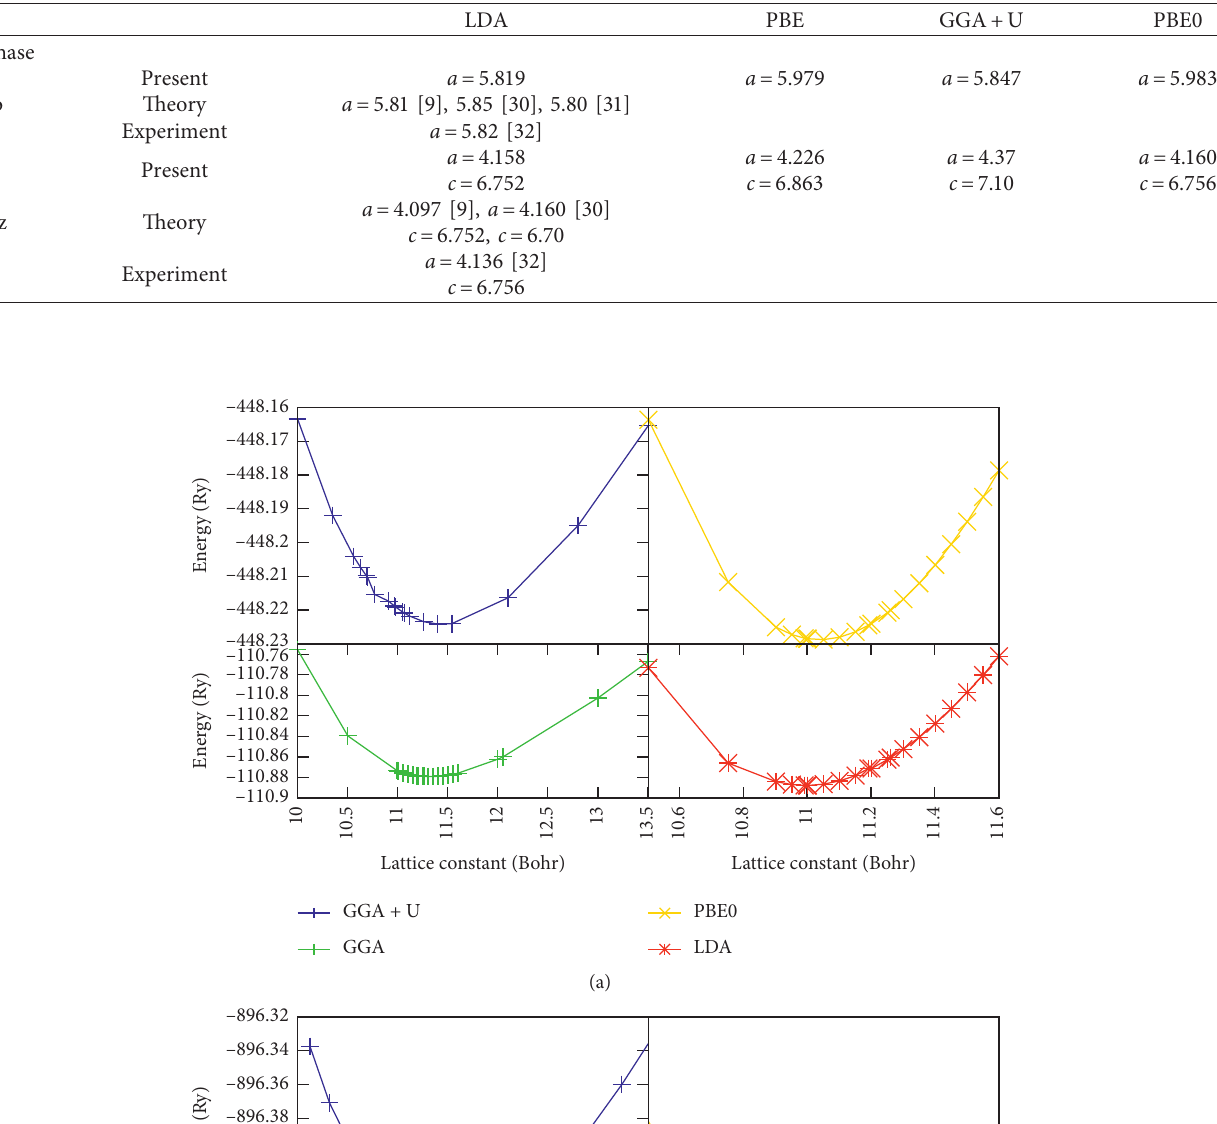
Table 1: Comparison of the calculated and experimental lattice constants.